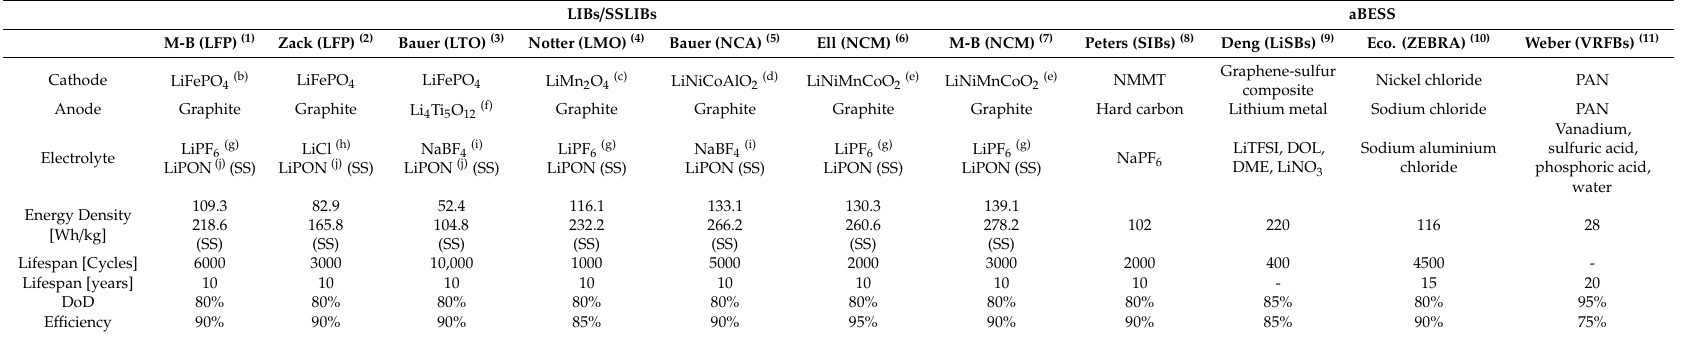
Table 1. Batteries operative parameters (a)